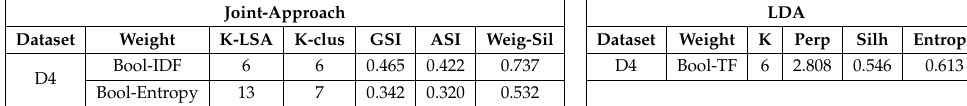
Table 8. Experimental results for